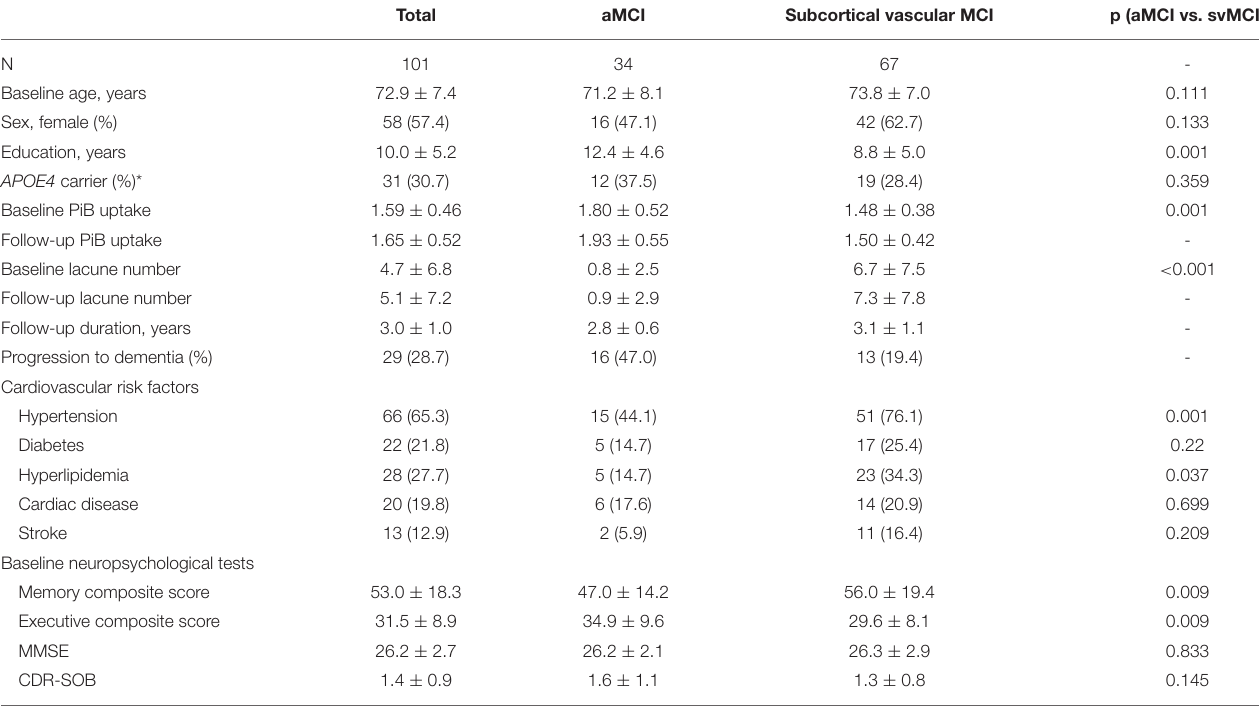
TABLE 1 | Demographic and clinical characteristics of the study participants. Total